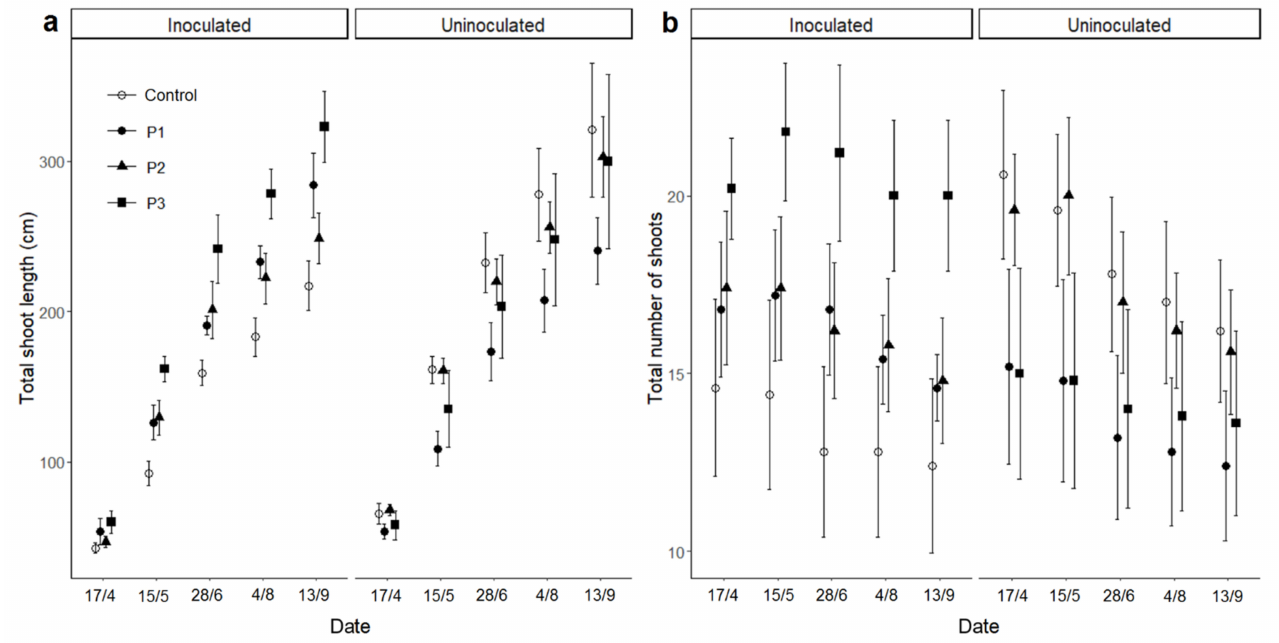
Figure 1. The average total shoot length (cm, ( a )) and total number of shoots ( b ) of inoculated and uninoculated Ajania plants treated with different phosphorus levels (P1, P2 and P3) and without phosphorus (control) in 2015. The vertical bars represent ± SE of the mean value (n = 5).